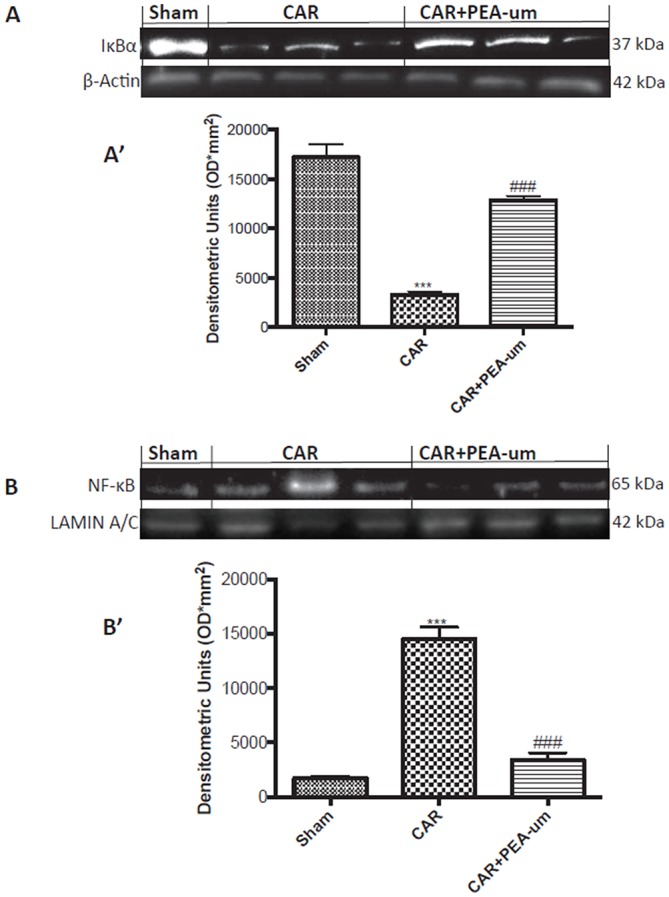
Effect of oral PEA-um on CAR-induced spinal IκB-α degradation and NF-κB p65 nuclear translocation. The levels of IκB-α significantly decreased in spinal cord tissue homogenates from CAR-injected rats, as compared to sham-treated rats (A,A'). Oral treatment with PEA-um (10 mg/kg) significantly recovered spinal IκB-α levels (A,A'). Further, levels of NF-κB p65 significantly increased in spinal cord tissue homogenates from CAR-injected rats (B,B'), and treatment with PEA-um significantly decreased NF-κB p-65 translocation. A representative blot of lysates obtained from five animals for each group is shown, and densitometric analysis of all animals is reported. Values are means ± SEM of five animals for each group. ###P < 0.001 vs. CAR; ***P < 0.001 vs. sham.